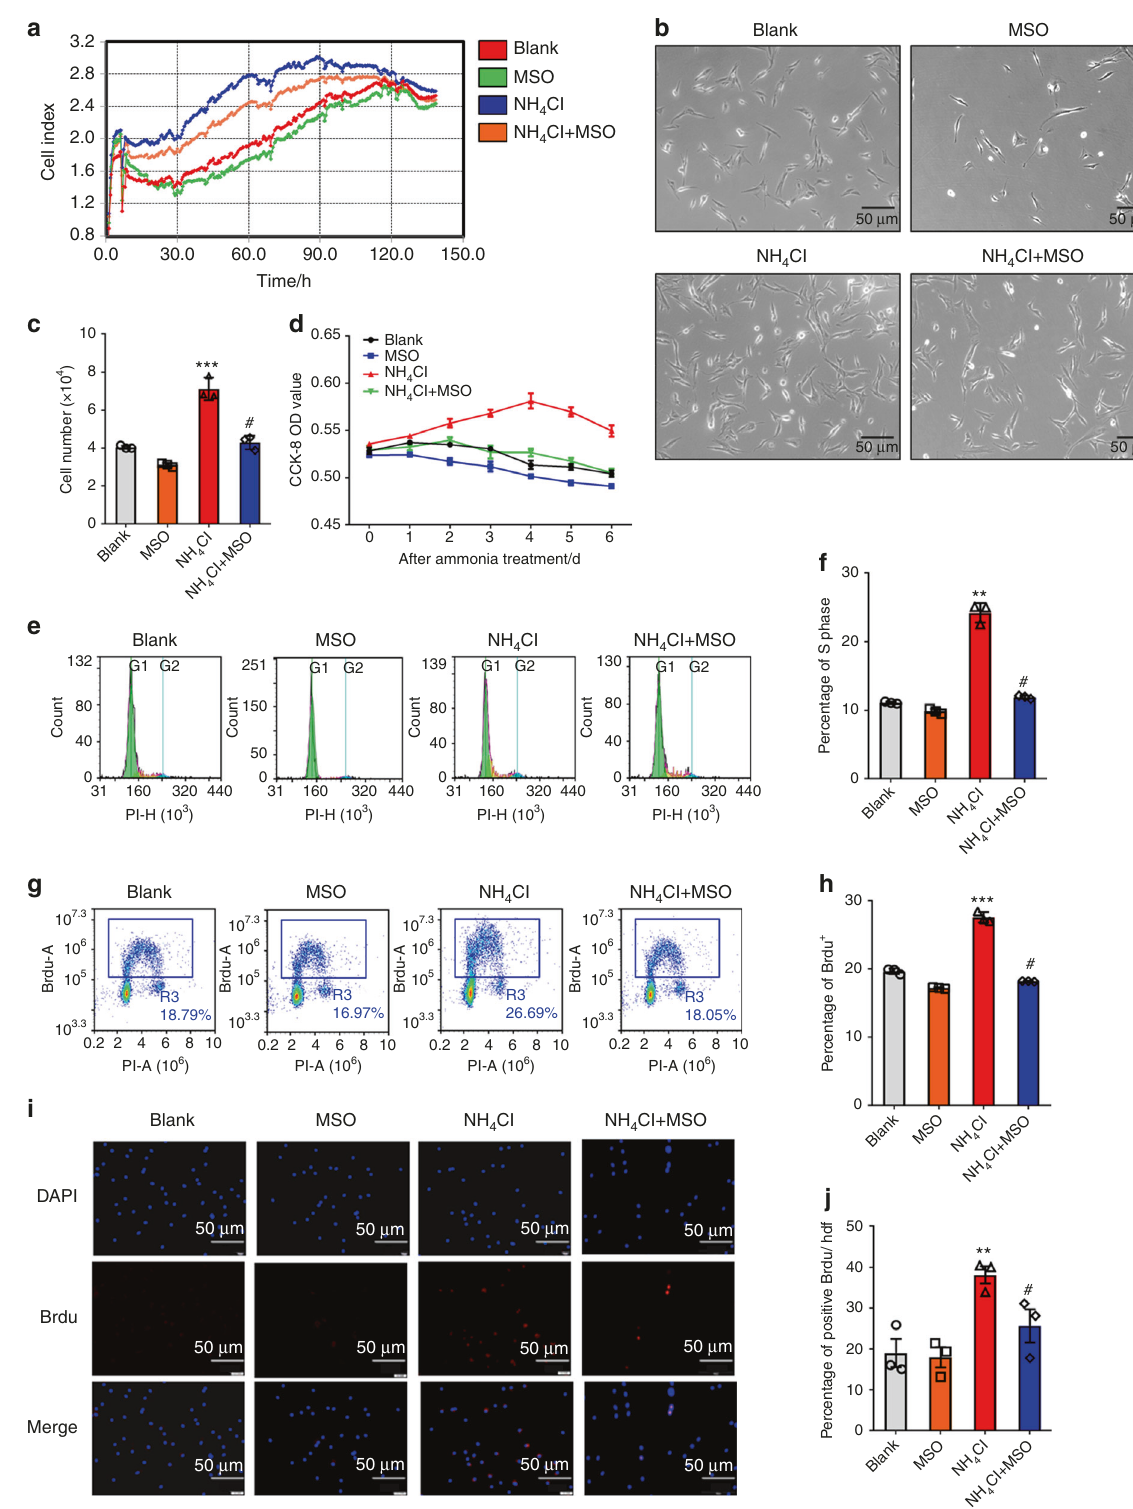
Fig. 4 Inhibition of glutamine synthetase reduces the ammonia-induced proliferation of mesenchymal stem cells. a RTCA (real-time cellular analysis) with or without both NH 4 Cl treatment or MSO treatment. b The growth of MSCs with or without both NH 4 Cl treatment and MSO treatment under a microscope. c The cell count results with or without both NH 4 Cl treatment and MSO treatment. d CCK-8 analysis with or without NH 4 Cl treatment or MSO treatment after 48 h (left) and lasting 1 week (right). e PI fl ow analysis. f The statistical results of the percentage of S phase cells. g BrdU fl ow analysis. h The statistical results of the percentage of BrdU + cells. i Immuno fl uorescence analysis of BrdU. j The statistical results of BrdU + cells/HPF. Values are the mean ± SEM of an experiment performed in triplicate (one-way analysis of variance). * P < 0.05 versus the controls. # P < 0.05 versus the 5 mmol·L − 1 NH 4 Cl treatment group